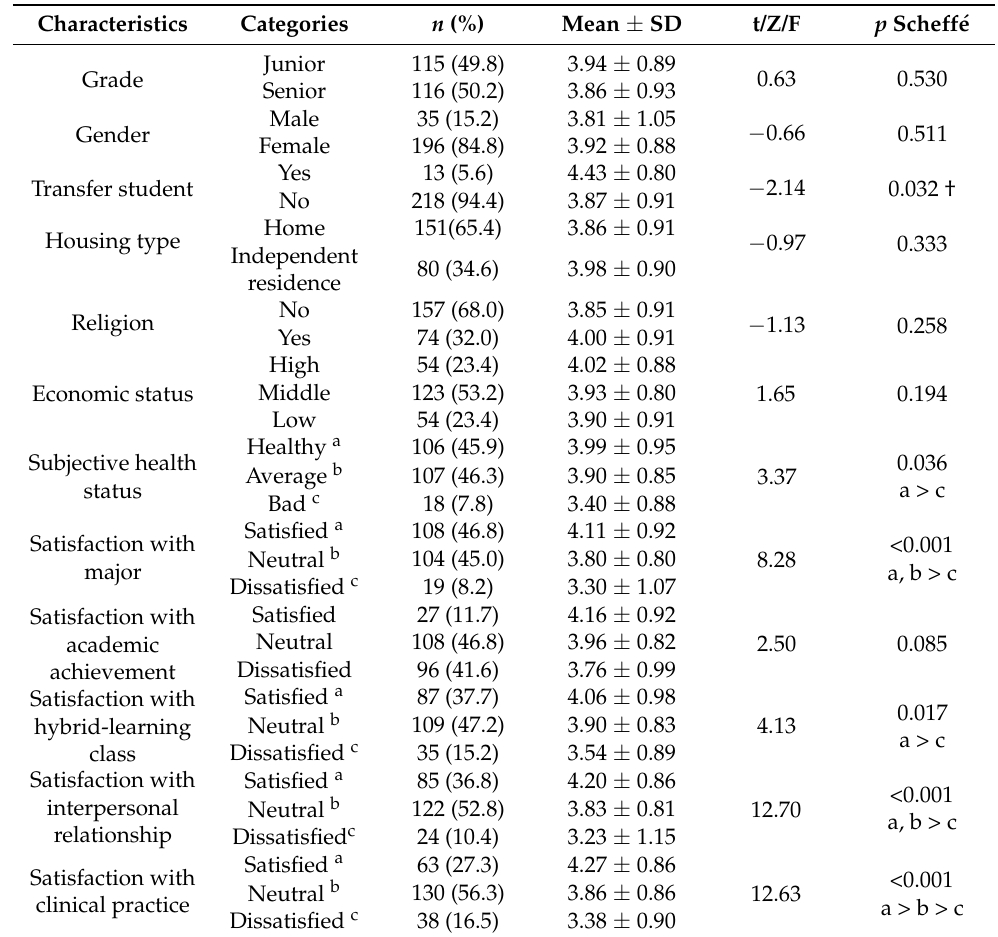
Table 1. Differences in post-traumatic growth by general characteristics (N = 231).